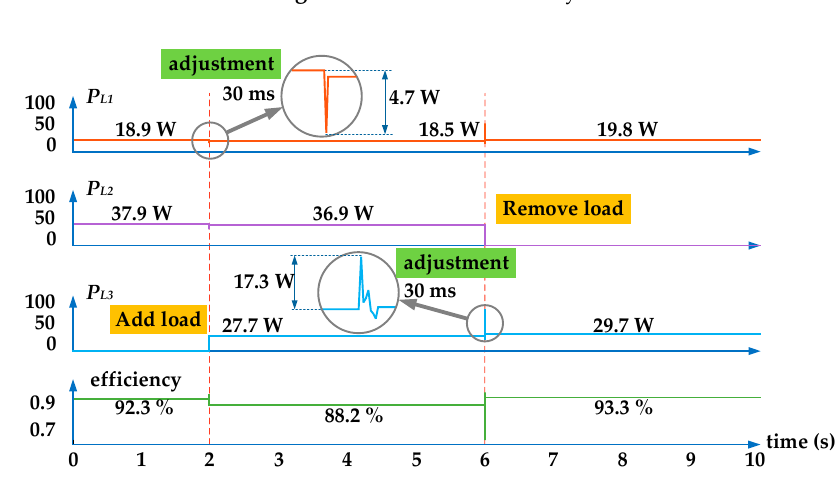
Figure 7. Power and efficiency. Energies 2018 , 11 , x